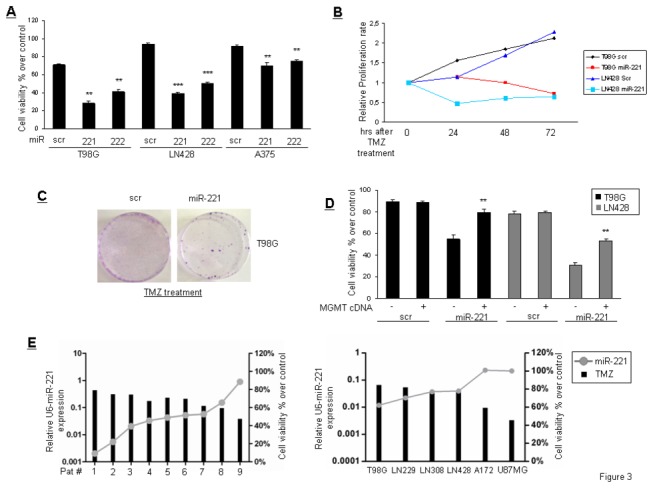
miR-221 modulates TMZ sensitivity.(A) Cell viability of T98G, LN428, and A375 cells transfected with miR-221 and miR-222 upon TMZ treatment (300 µMol) for 24 hrs. **p value<0.0082 versus scr column, ***p value<0.005 versus scr column. (B) Growth curve of T98G and LN428 cells transfected or not with miR-221 after 24 hrs of treatment with TMZ. (C) Colony assay of T98G and LN428 cells transfected with miR-221 and then treated for 24 hrs with TMZ (300 µMol). Cells were left to grow for 6 days after treatment removal. (D) MGMT expression rescues cell viability after TMZ treatment in T98G and LN428 cells overexpressing miR-221 **p value<0.0082 versus untransfected MGMT column. (E) Correlation between miR-221 expression and TMZ sensitivity in nine primary glioblastoma cell lines and in six glioblastoma cell lines.